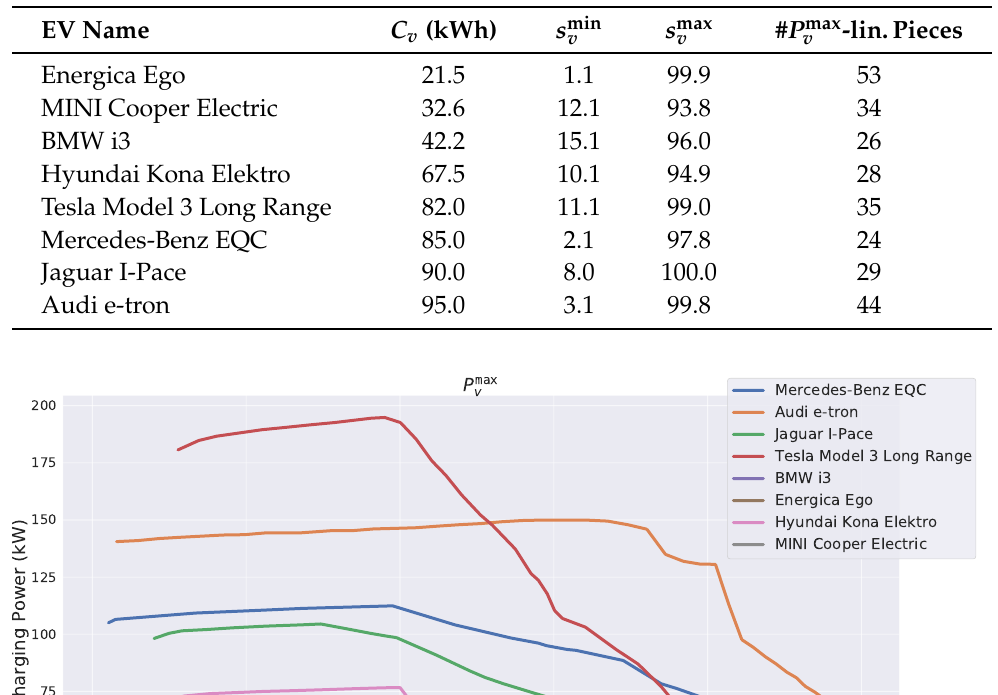
Table 1. Used EV types with battery capacity C v , P max v domain [ s min v , s max v ] and the number of linear pieces of P max v